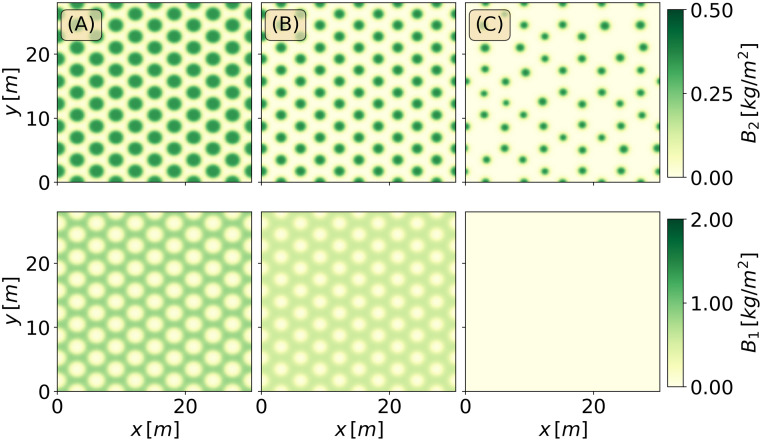
Precipitation downshift for the spots patterns.Time integration of the spots patterns for a downshift of the mean annual precipitation from P = 600mm/y (in (A)), to P = 400mm/y (in (B)), and to P = 200mm/y (in (C)), over a period of T = 100y.